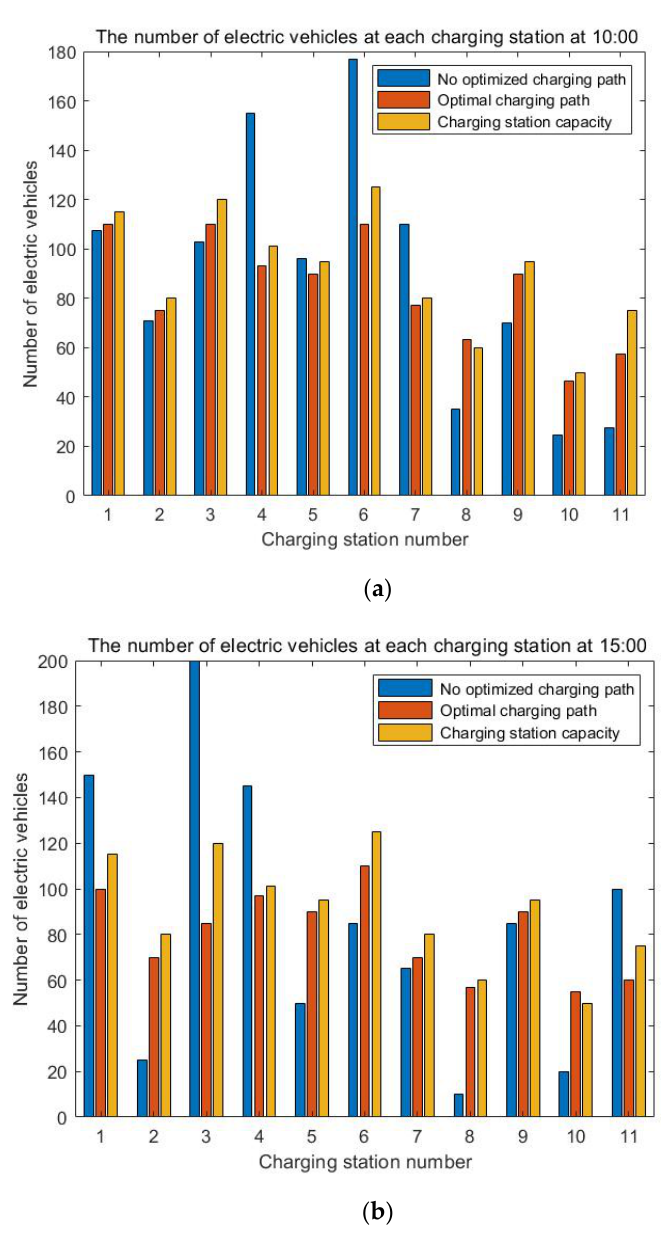
Figure 8. “Double peak” time charging station load comparison. ( a ) Comparison of the number of electric vehicles at each charging station at 10:00; ( b ) Comparison of the number of electric vehicles at each charging station at 15:00.